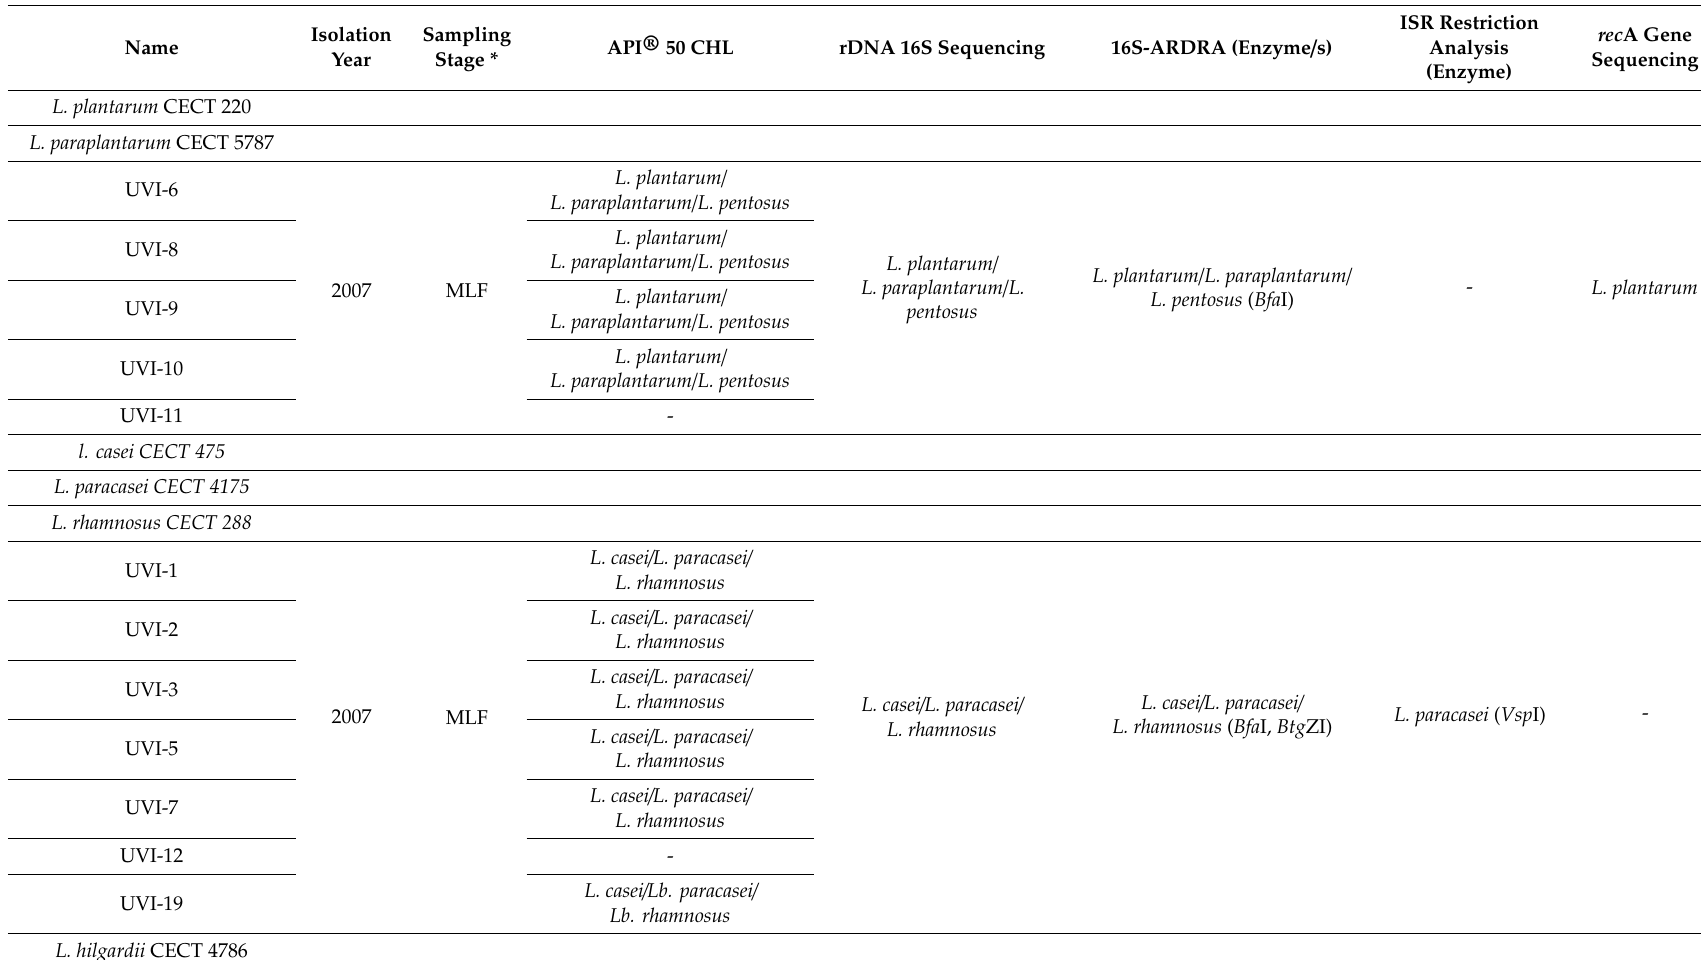
Table 1. Identification of lactic acid bacteria (LAB)